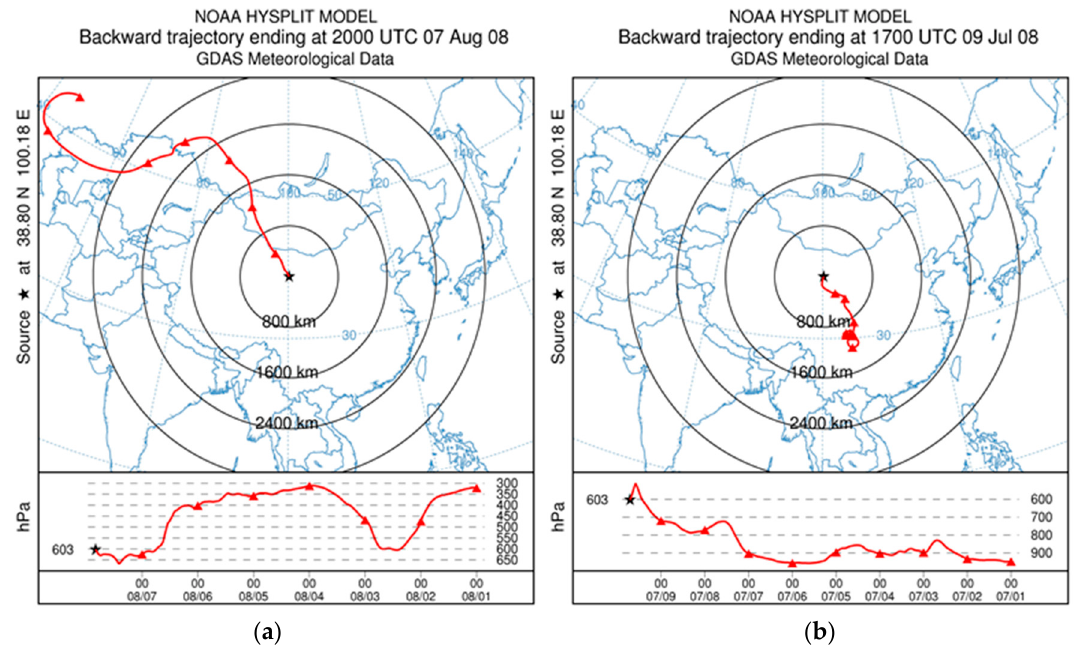
Figure 5. Two typical cases of air mass back trajectories of individual precipitation events by the Hysplit model for ( a ) 2008.8.7 at Yingluoxia station and ( b ) 2008.6.9 at Yingluoxia station. Table 3. Analysis of precipitation from different water vapor sources in the upper reaches of the Heihe River Basin from 2007.10 to 2008.9. The number of precipitation samples from different sources for each site is given in the column labeled